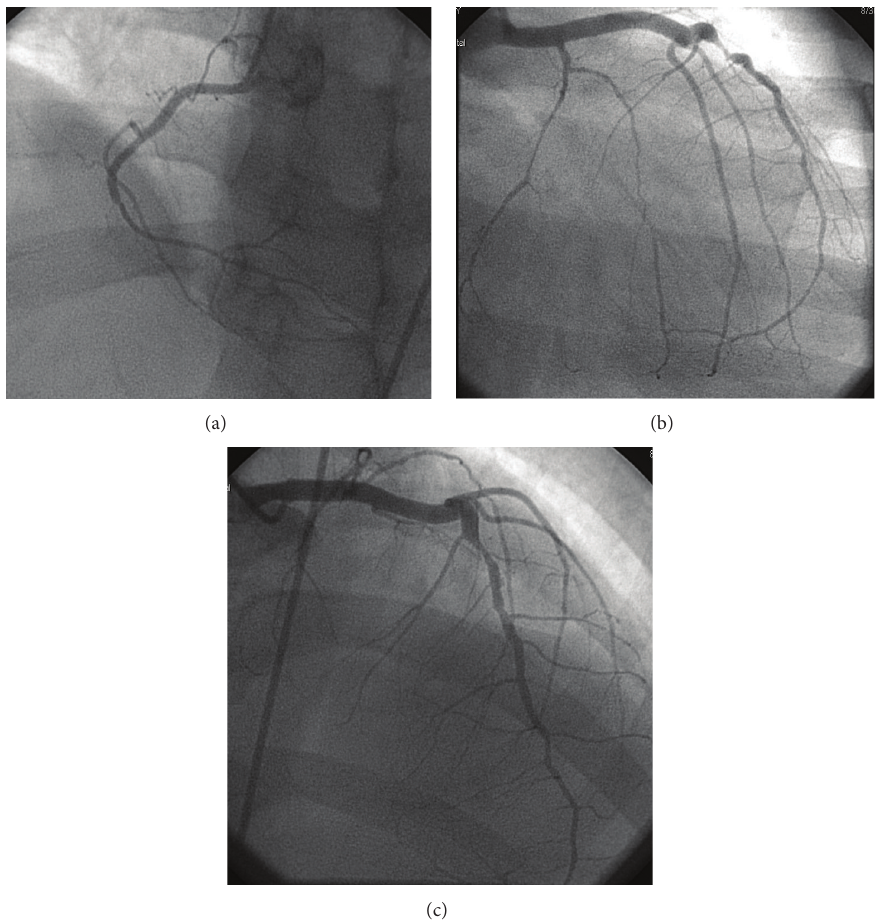
Figure 2: (a) Narrowing of the right coronary artery (RCA) is observed. (b) Narrowing of the left anterior descending (LAD) and left circumflex arteries is observed. (c) Narrowing of the LAD is